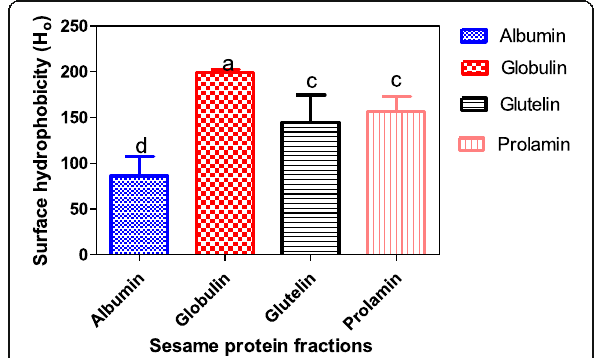
Fig. 3 Surface hydrophobicity of sesame protein